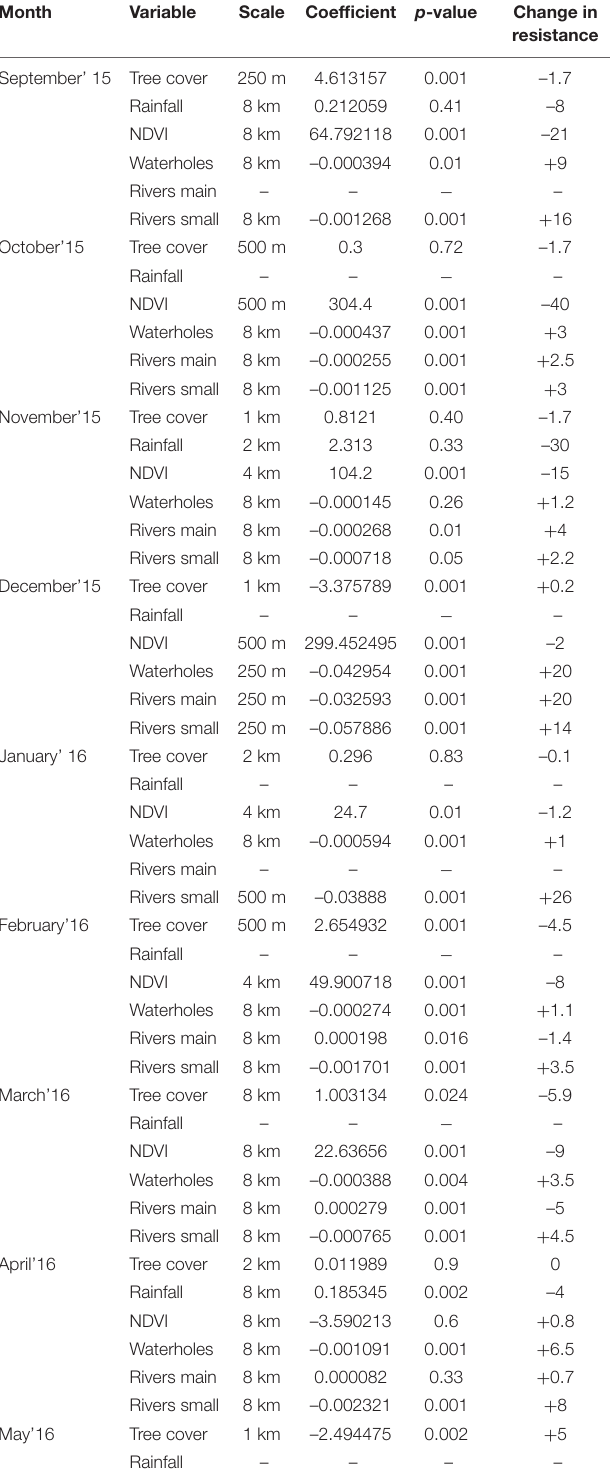
TABLE 1 | Monthly movement models, with coefficients, best scales selected through scale-optimization process, and a variable importance measured by change in resistance value when a variable changes from 10th percentile to 100th